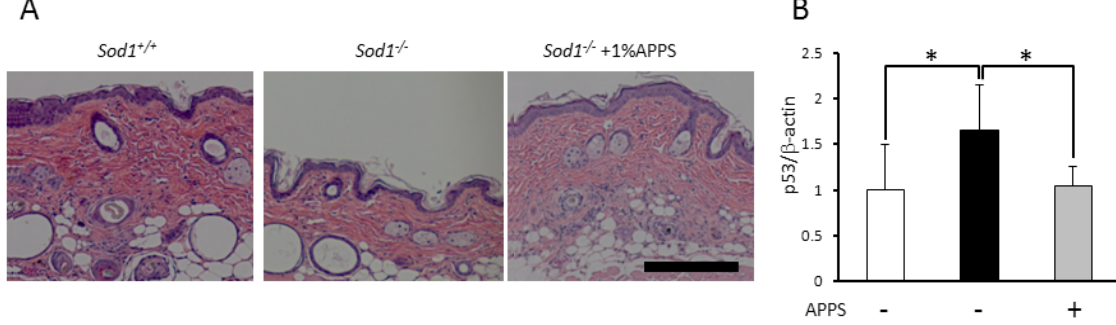
Figure 5. A VC derivative rescues skin phenotypes in Sod1 − / − mice. ( A ) The hematoxylin and eosin staining of the back skin of Sod1 − / − and Sod1 +/+ mice. Sod1 − / − mice (5 months old) were transdermally treated with 1% APPS for 4 weeks. The scale bar represents 100 μ m; ( B ) p53 mRNA expression was analyzed by quantitative PCR in skin tissues with or without APPS treatment ( n = 6–7). These data indicate the mean ± SD; * p <